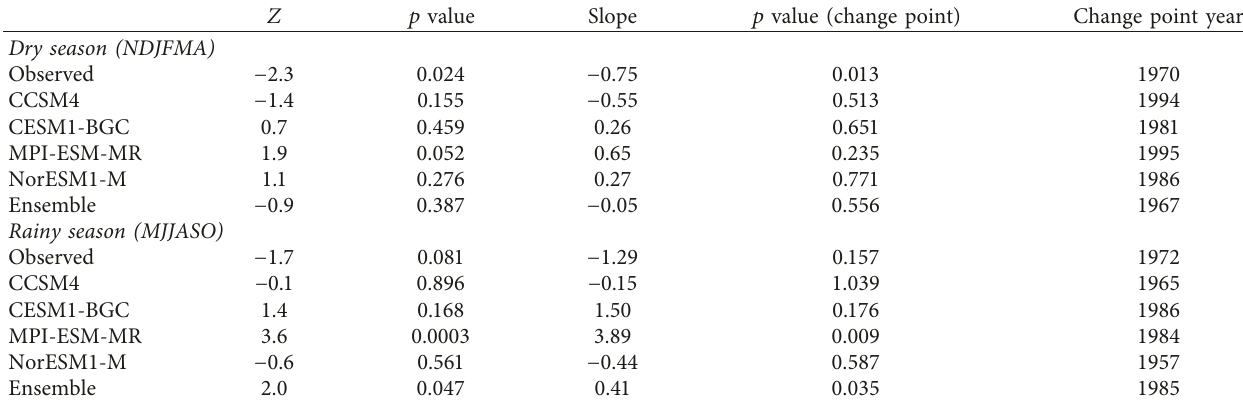
Table 4: Trend test for the Soudano-Sahel rainy and dry seasons.